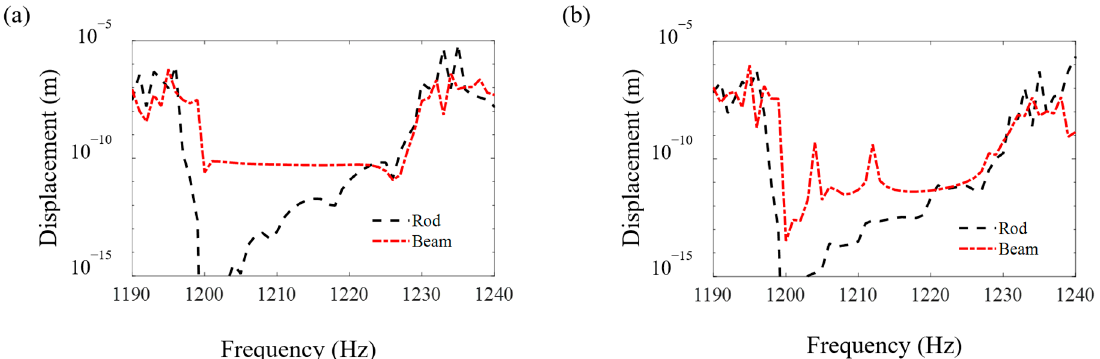
Figure 9. The FRF curves of the metamaterial plates with the beam cores and rod cores near the second axial vibration band-gaps in the z direction of the beams at points A and B of the cover plates. ( a ) Point A and ( b ) point B .